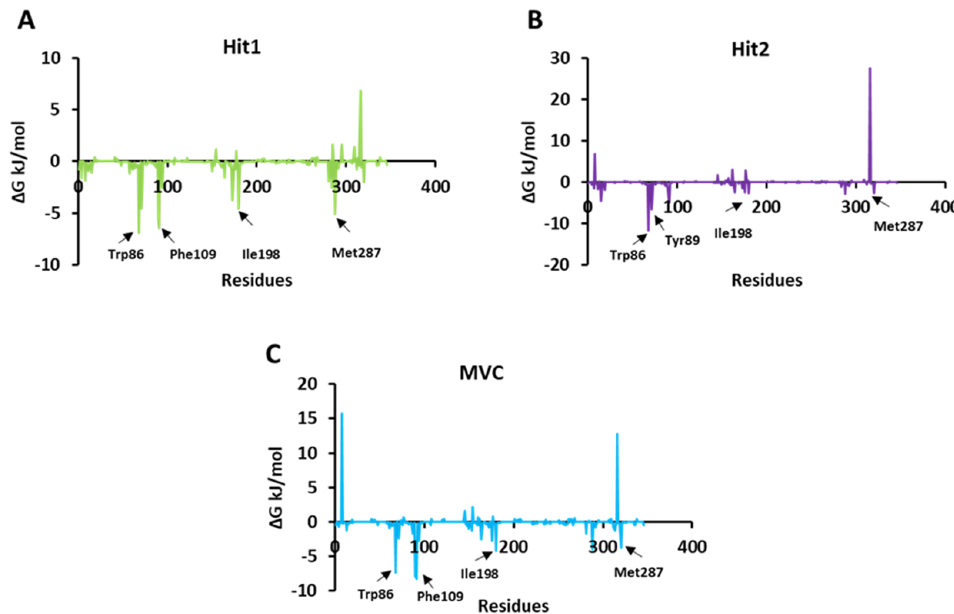
Figure 7. Per residue energy contribution of each simulated system of Hit1, Hit2, and reference to binding free energy. ( A ) Hit1 is represented in green color; ( B ) Hit2 in violet color; and ( C ) MVC (reference) is shown in blue color.